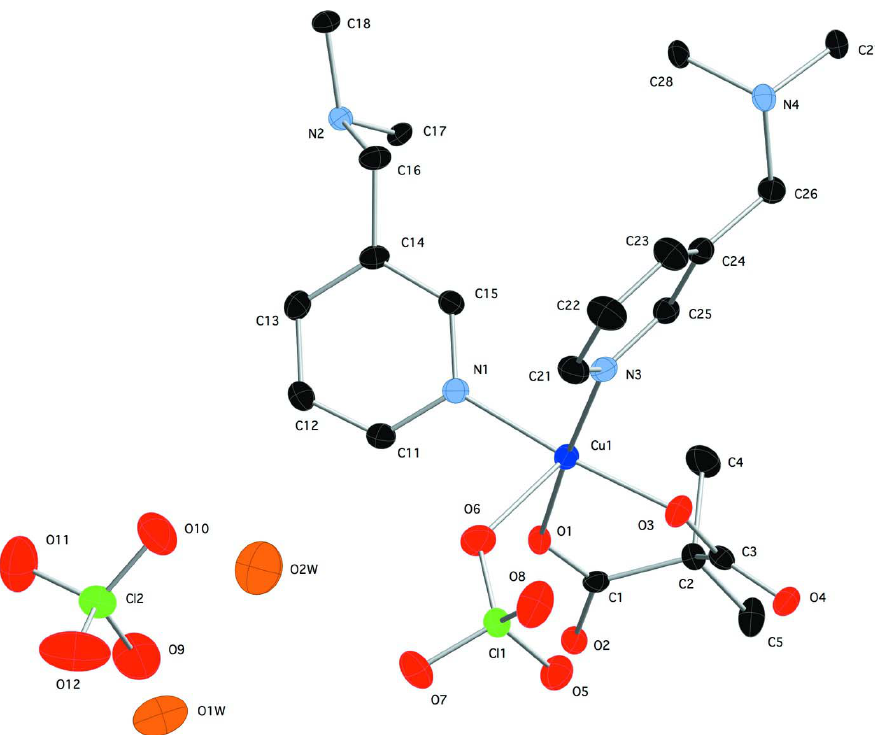
Figure 1 Coordination environment of the title compound, showing 50% probability ellipsoids and atom numbering scheme. Hydrogen atoms are not shown. Color codes: dark blue Cu, light blue N, red O, black C, green Cl and orange O atoms of water molecules.